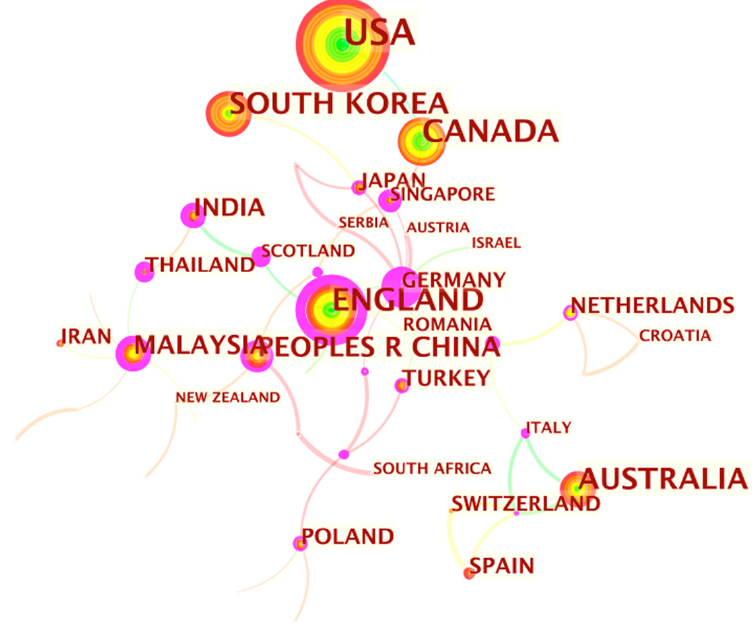
Figure 3. Country of origin of authors in medical-health-wellness tourism.